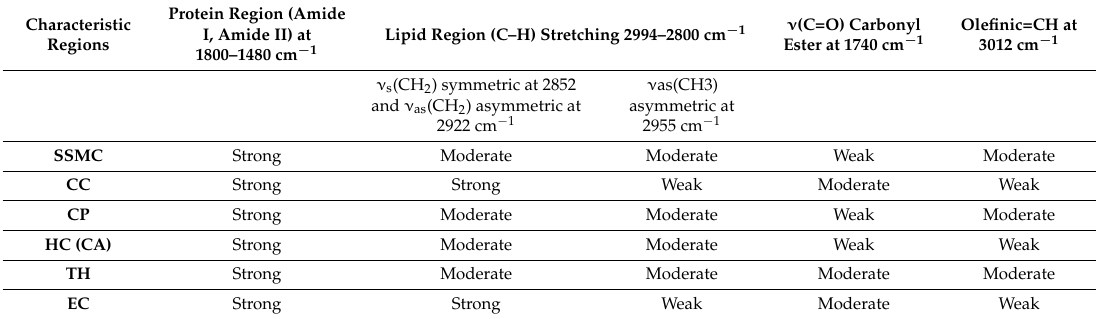
Table 3. Identification and differentiation of the regions of interest (ROI), within the brain sections. Characteristic Regions